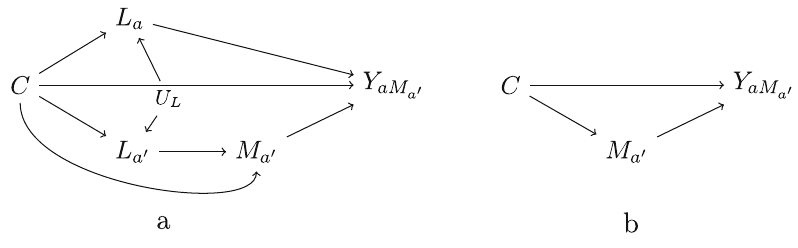
. ( a ) The general case and ( b ) the special case with no L a ′